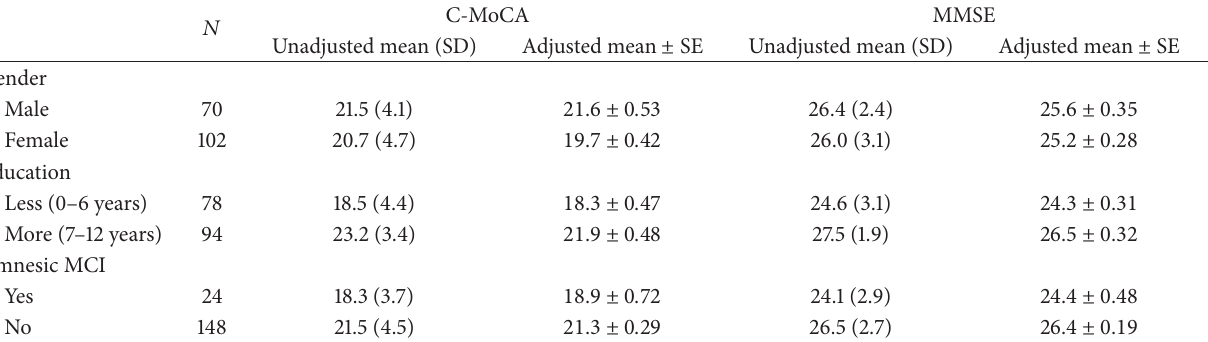
Table 2: Unadjusted and adjusted mean C-MoCA and MMSE scores by gender, education, and aMCI diagnosis.